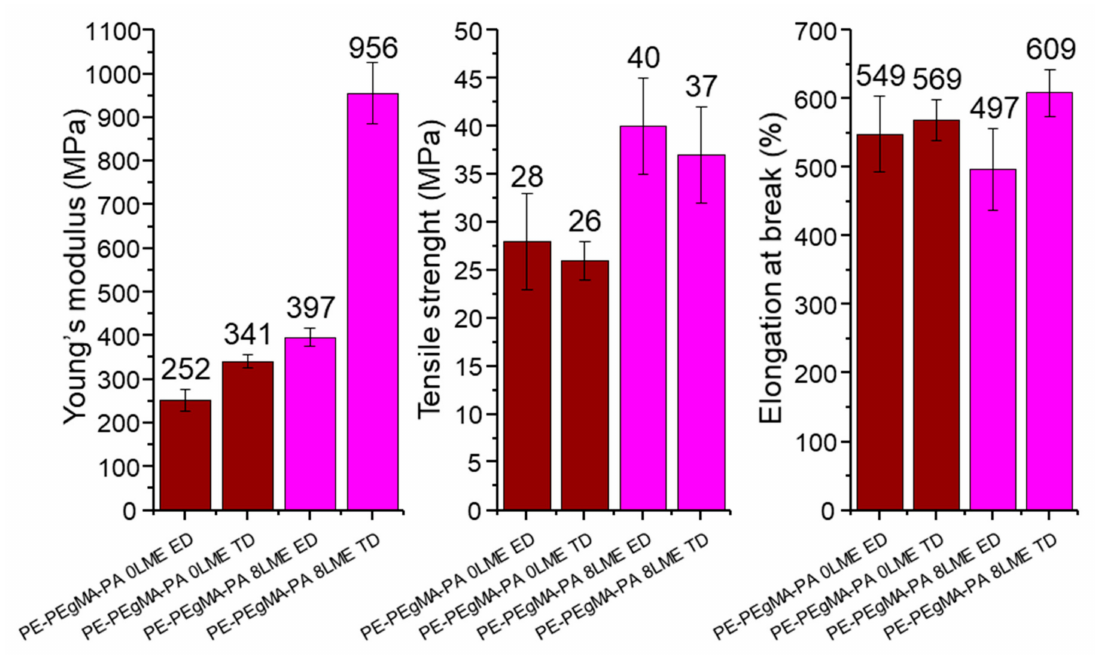
Figure 11. Mechanical properties in extrusion direction (ED) and transverse direction (TD) of PE/PEgMA/PA6 multilayer films extruded with 0LME (5 layers) and with 8LME (1029